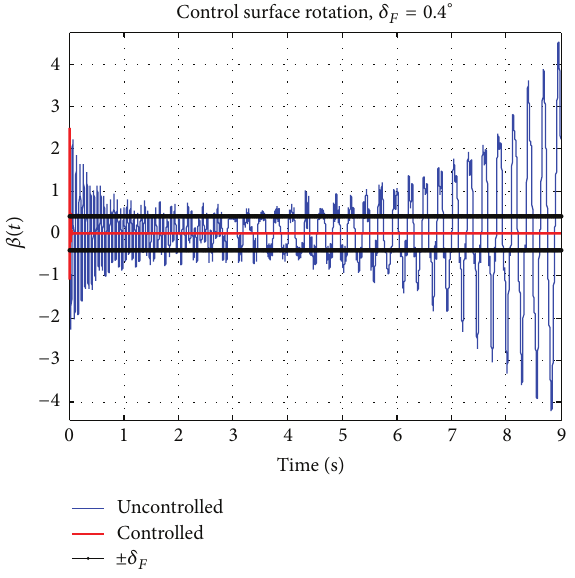
Figure 16: Case 2: control surface rotation ( |𝛿| = 0.6 ∘ and 𝑉 = 13.1 m/s).